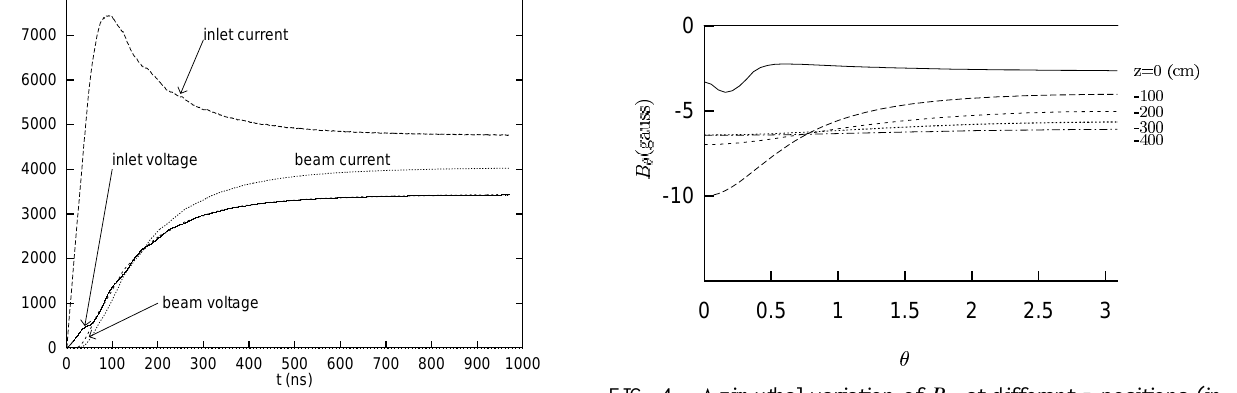
FIG. 2. Inlet and AK current and voltage vs time.